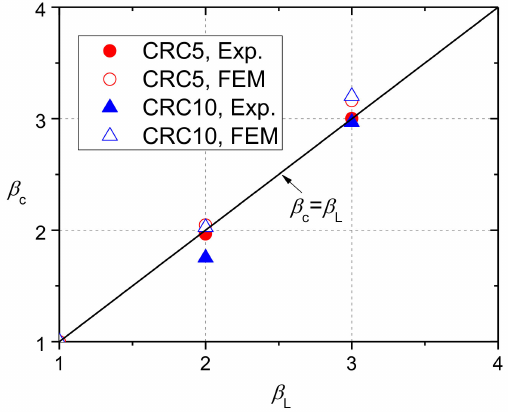
Figure 21. Comparison between the values of β c from finite element models (FEM) and experiments.